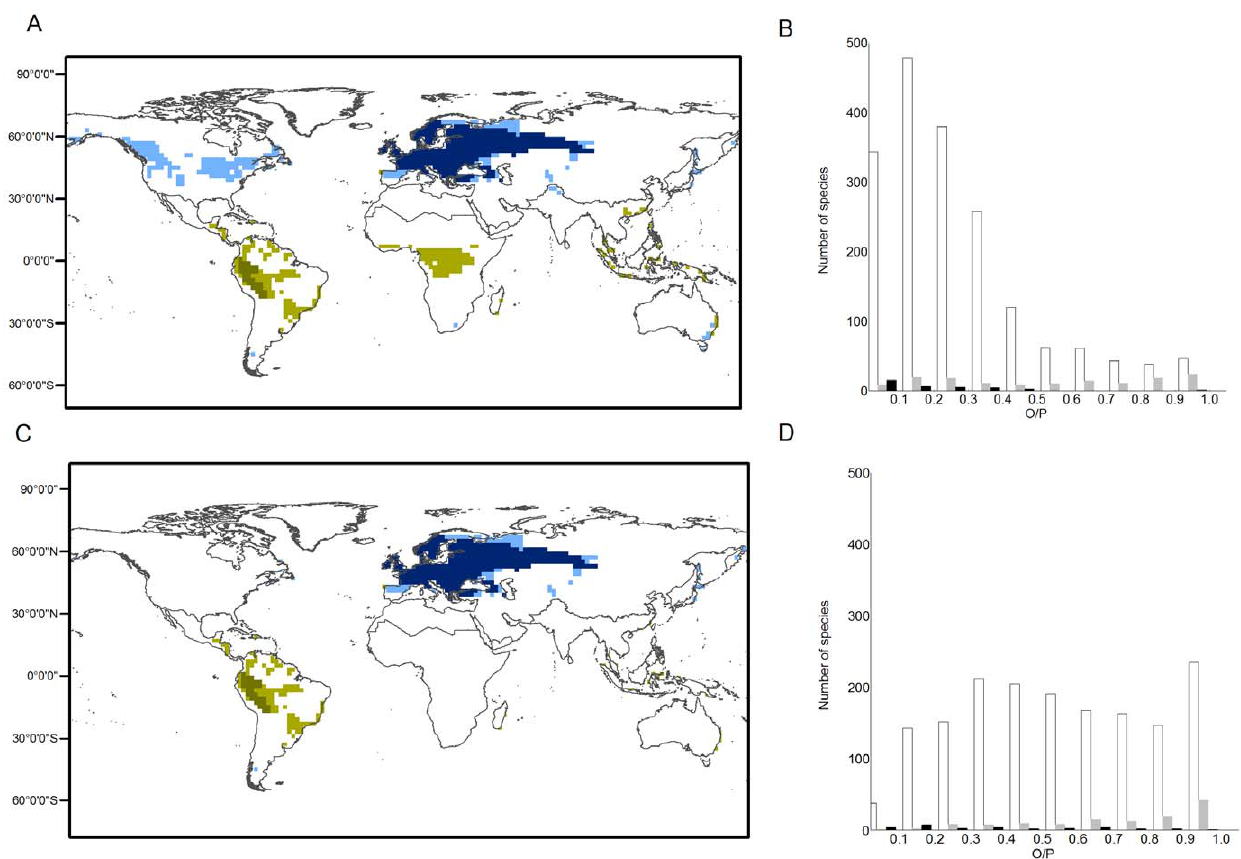
Figure 1. Observed and modeled potential distributions for two selected species: Lissotritonvulgaris (Salamandridae, Caudata) in the Palearctic region (Blue) and Chiasmocleisventrimaculata (Microhylidae, Anura) (Green) in the Neotropic region. Dark colors are observed distributions and light colors are potential distributions; the smaller the difference between observed and potential distributions, the greater the expected equilibrium of species with climate. (A) Global analysis, in which models calibrated for species occurring in a particular biogeographical region are allowed to project climate space globally; (C) regional analysis, in which models are not allowed to project climate space beyond the biogeographical region in which the species occurs. Frequency distribution of equilibrium values ( O = P ) at the (B) global and (D) regional scales. White bars represent Anura, shaded represent Caudata, and black represent Gymnophiona.